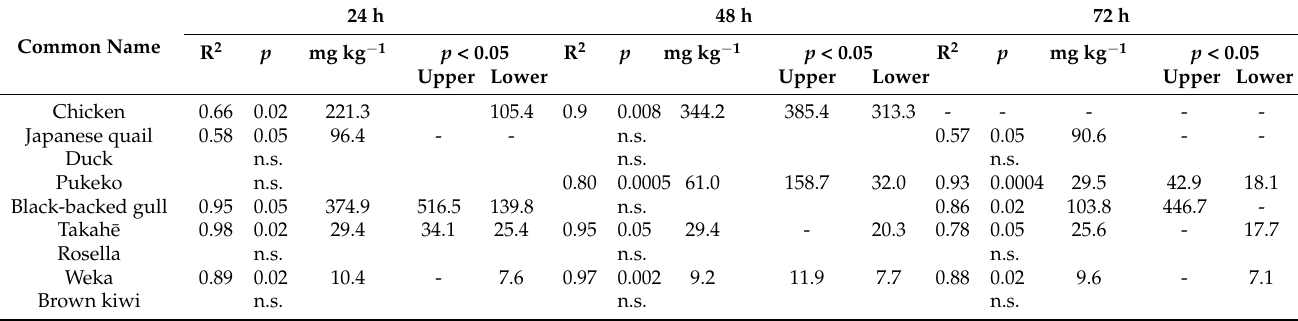
Table 5. Goodness of fit (R 2 ) and significance ( p ) for model of PAPP doses (mg kg − 1 ) given at T0 when projected to exceed 2 SDs of the mean T0 value for haemoglobin (HbFe 2+ ) at 24, 48 and 72 h with upper and lower confidence ( p < 0.05). Null results denote that no shifts beyond 2 SDs were